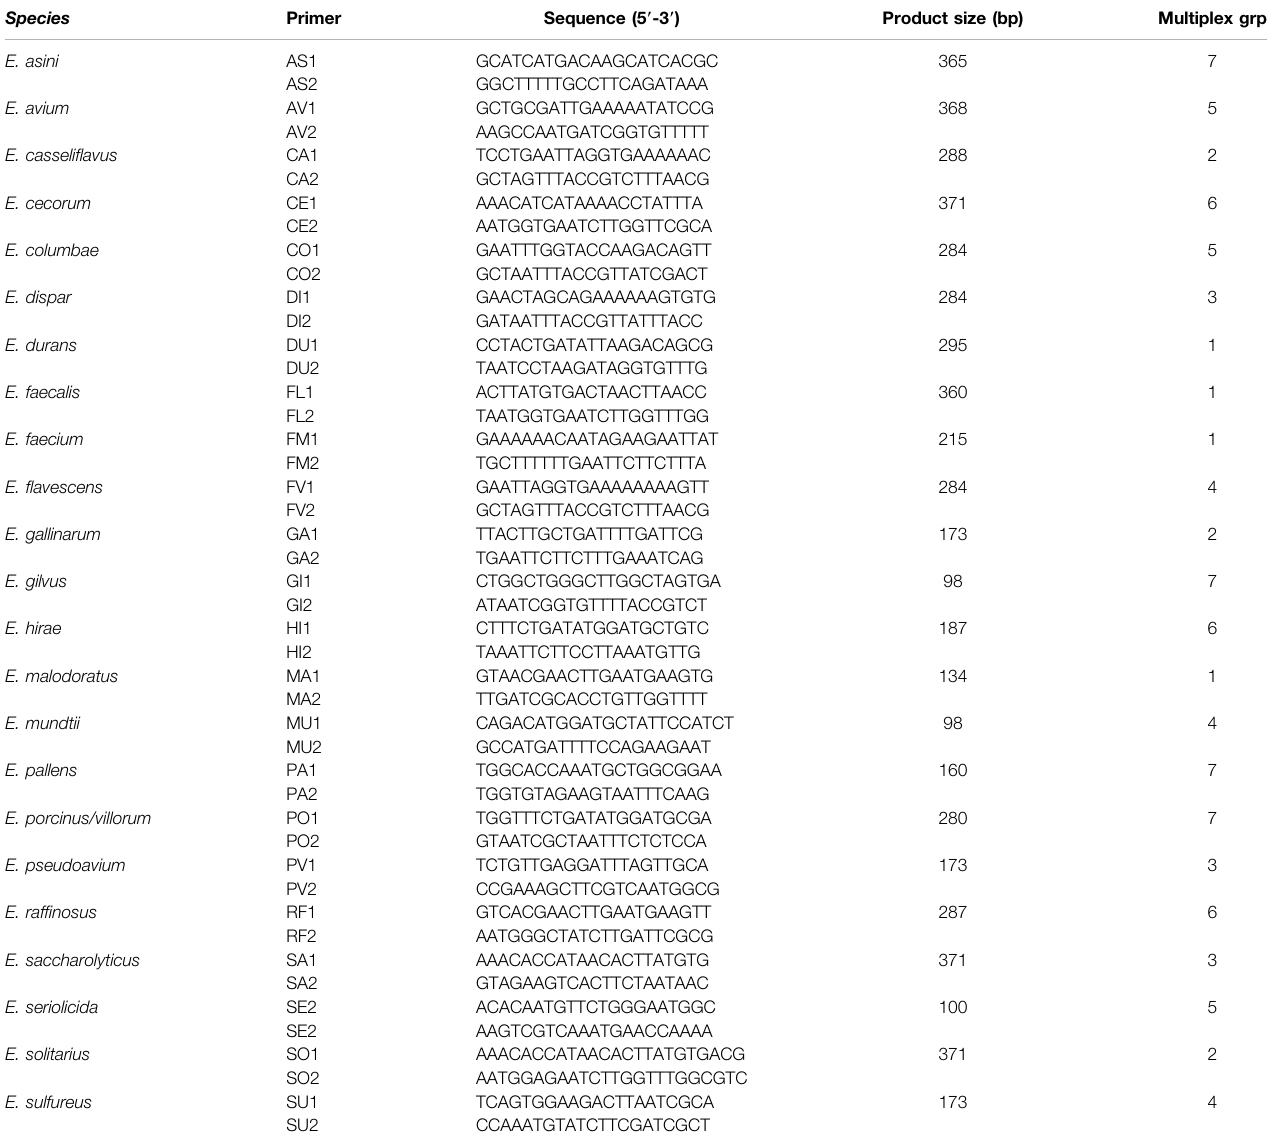
TABLE 1 | Primers for species-speci fi c identi fi cation of Enterococcus .